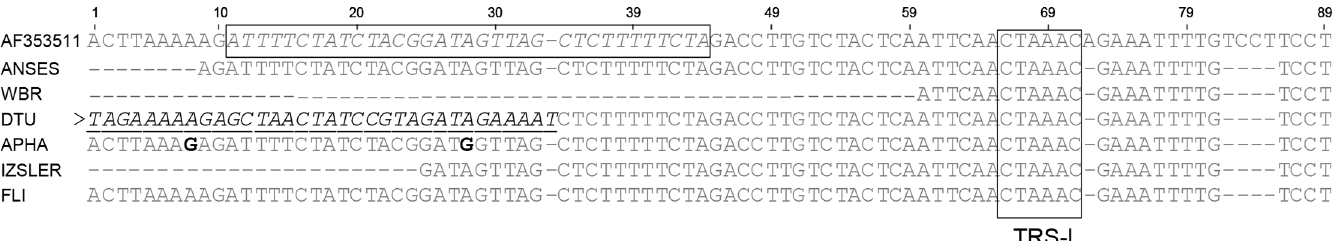
Fig 4. Alignment of the 5´-terminal sequences of the PEDV genomes. From nt 34 of the AF353511 reference sequence the different sequences align well but the reference sequence contains an insertion of one nt (nt 72) and a duplication of 4nt (see nt 82–89) that are absent in each of the other sequences. Due to the sequencing strategies used not all the sequences are complete. The Br1/87 (DTU) terminal sequence is extensively rearranged (see text for details) and contains a region (in black italics) that is the “reverse complement” of part of the reference sequence (boxed italics). Two single nt changes were found in the APHA sequence, marked in bold type, one change was shared with the ANSES sequence. The TRS-L is also indicated. The > symbol indicates that additional sequence is present (but not shown here) at the 5´ terminus in the DTU sequence.